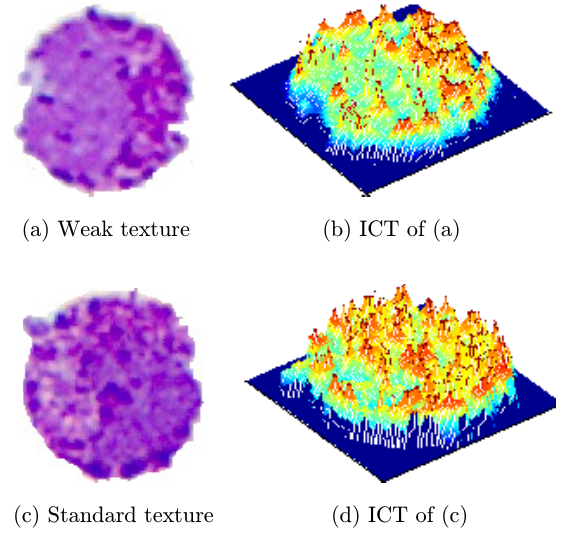
Fig. 9. Di®erent repeatability in the same type of